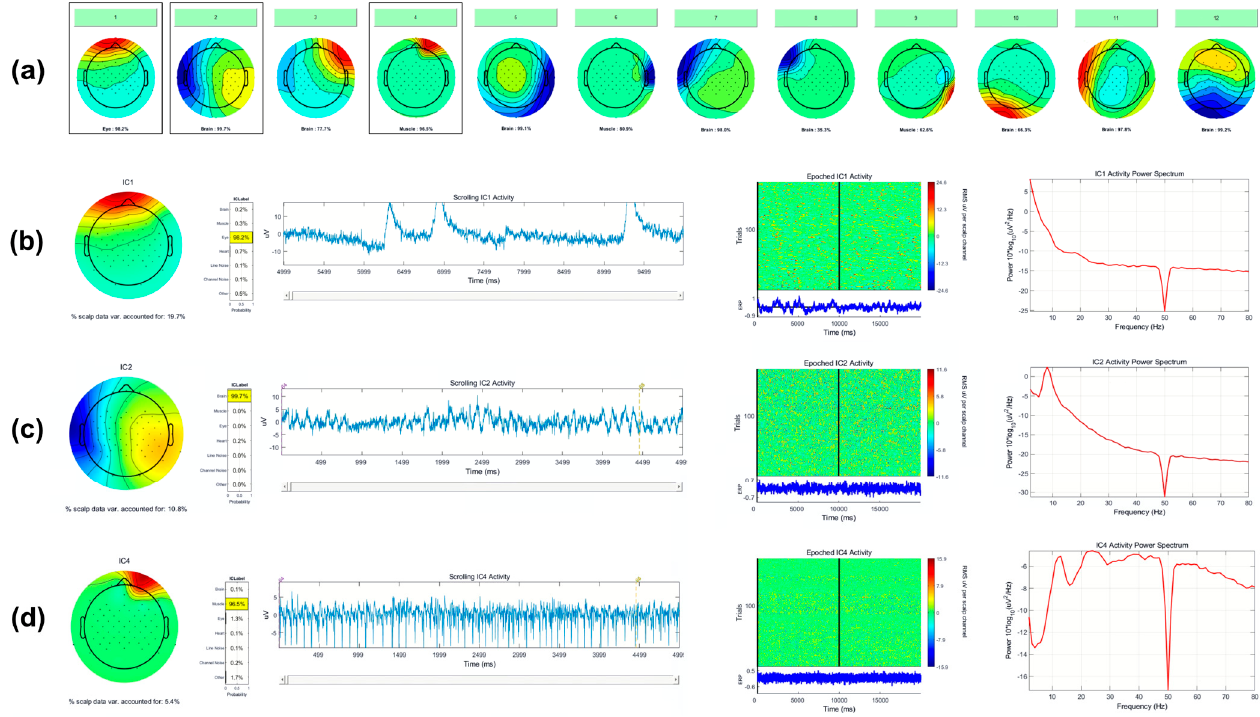
Figure 6. ( a ) Example output from EEGLABs IClabel function, indicating the probability of each IC’s class. Here, ICA components 1, 4, 6, and 9 are classified as eye and muscle activity, whereas 2, 3, 5, 7, 8, 10, 11, and 12 are classified as brain activity. Profiles of outlined ICs 1, 2, and 4 are shown in detail. ( b ) Detailed view of IC 1, eye. ( c ) Detailed view of IC 2, brain. ( d ) Detailed view of IC 4,